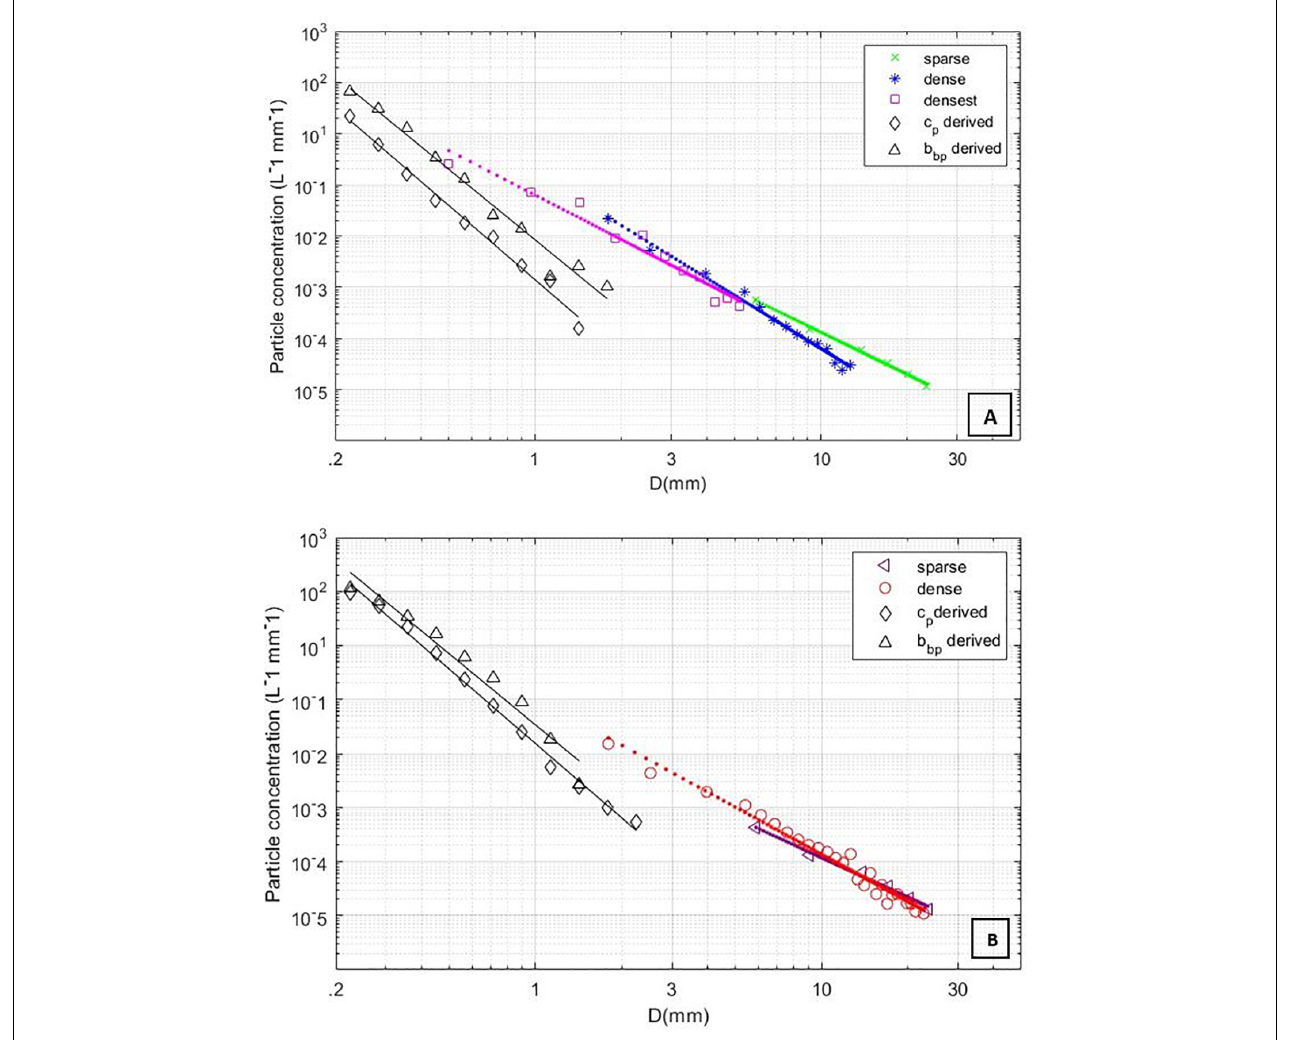
FIGURE 10 | (A) Sparse, dense, and densest lidar derived PSDs with b bp and c p derived PSDs for dusk time series. (B) Sparse and dense lidar derived PSDs with b bp and c p derived PSDs for dawn time